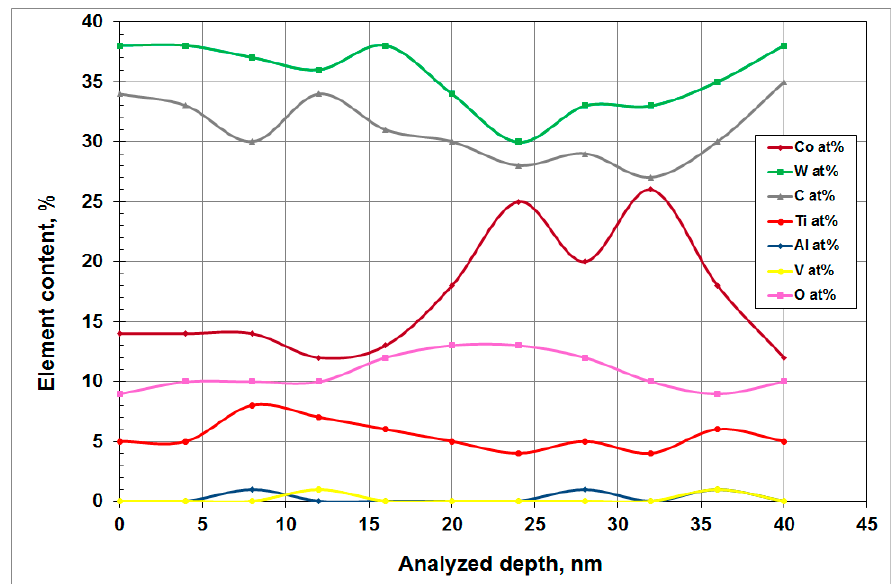
Figure 21. In-depth Auger analysis in the Co phase of the carbide (point P).